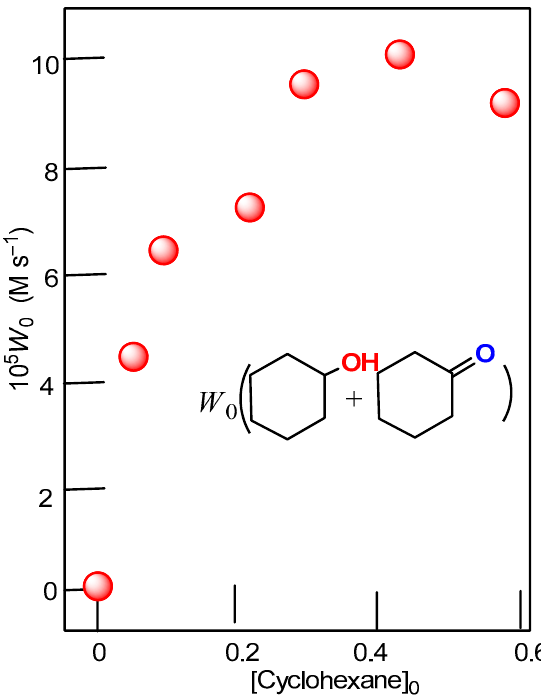
Figure 7. Dependence of the initial rate of oxygenate formation W 0 on initial concentration of cyclohexane (0.46 M) for the oxidation of cyclohexane with system: complex 2 (5 × 10 − 4 M)/H 2 O 2 (2.0 M)/PCA (2 × 10 − 3 M), at 50 ◦ C in